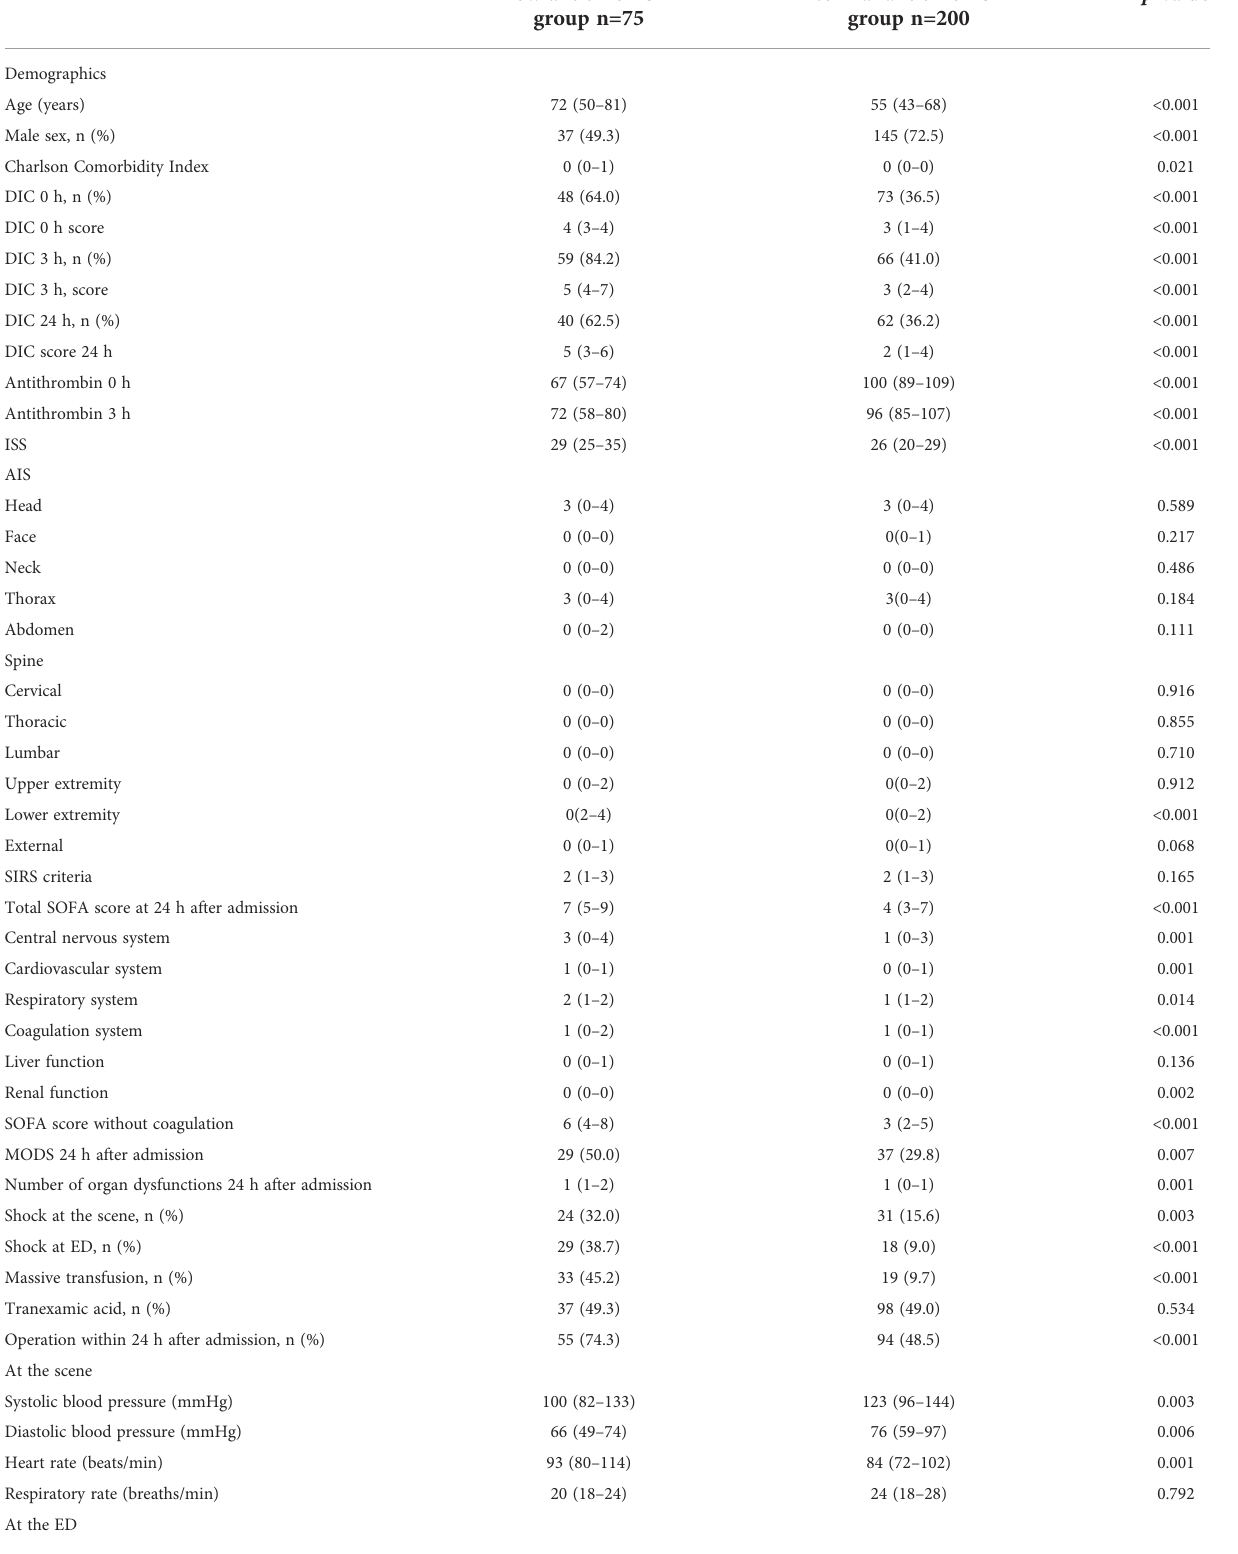
TABLE 1 Demographics, parameters at the scene and admission to the emergency department, volume of transfusion, and mortality in the study